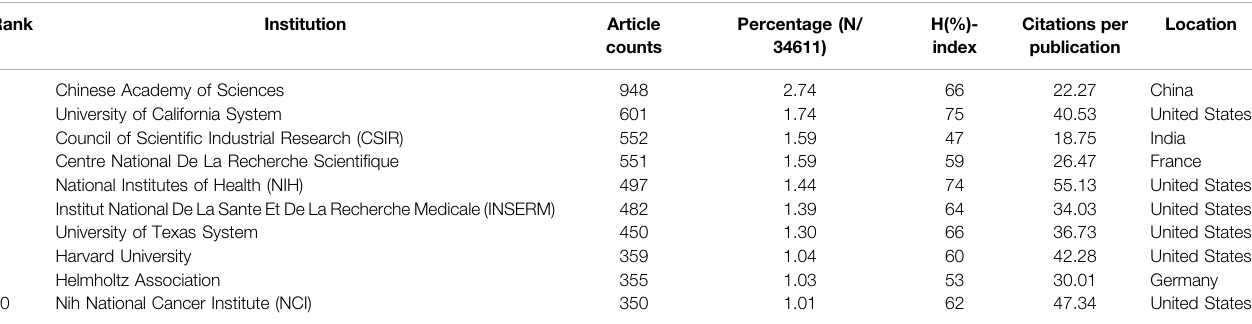
TABLE 2 | The top 10 productive institutions related to natural products in cancer research. Institution